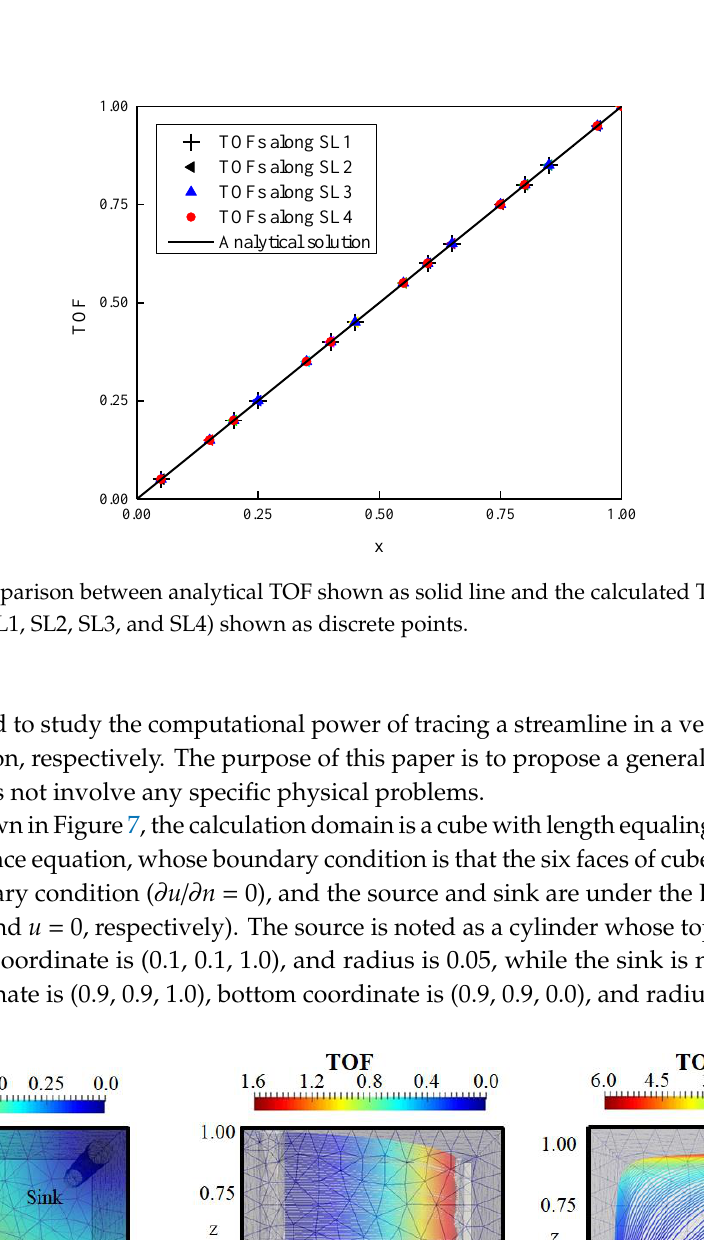
Figure 7. The result of Case 2. ( a ) The discretization of the calculation domain and the potential field (u), ( b ) and ( c ) show the streamline pattern from the x-y plane view and x-z plane view, respectively.